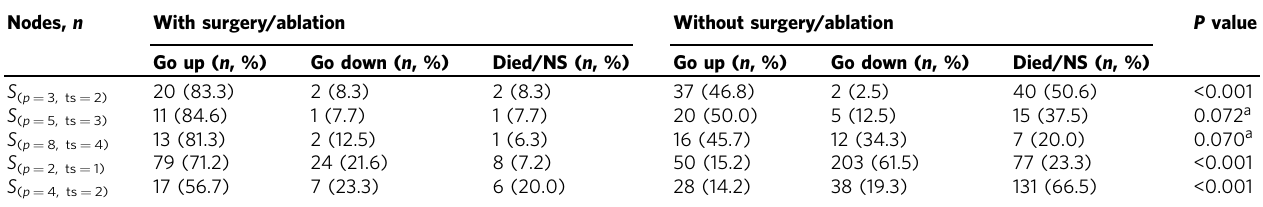
Table 5 The correlation between surgery/ablation and path transfer in KEY nodes Nodes, n With surgery/ablation Without